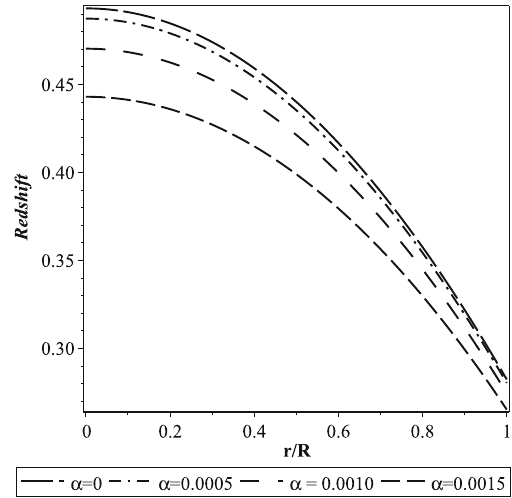
Fig. 8 Variation of the redshift function with respect to the radial coor- dinate r / R for the strange star LMC X −